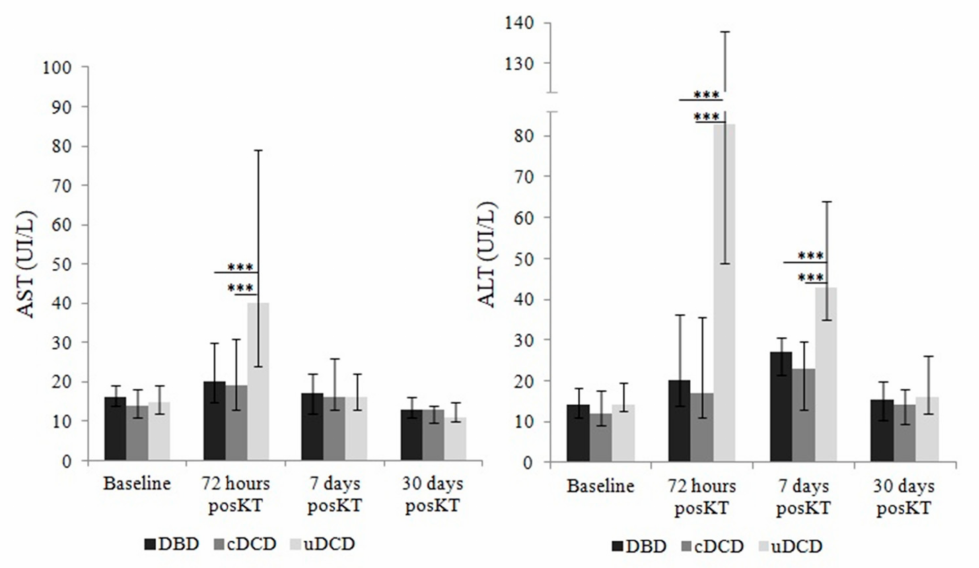
Figure 4. Dimension of AST and ALT elevation according to donor type (only those recipients who received thymoglobulin) represented as medians and interquartile range. Comparisons between groups were made with Mann-Whitney U test. Differences were found in the uDCD group at 72 h post-KT (AST levels) and at 72 h and 7 days post-KT (ALT levels). *** p < 0.001.